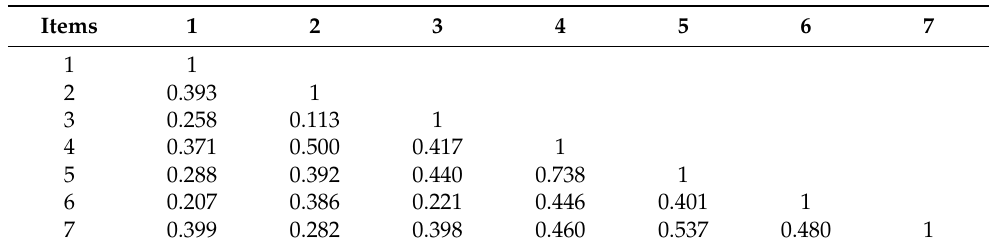
Table 5. Polychoric correlation matrix for 7 items.